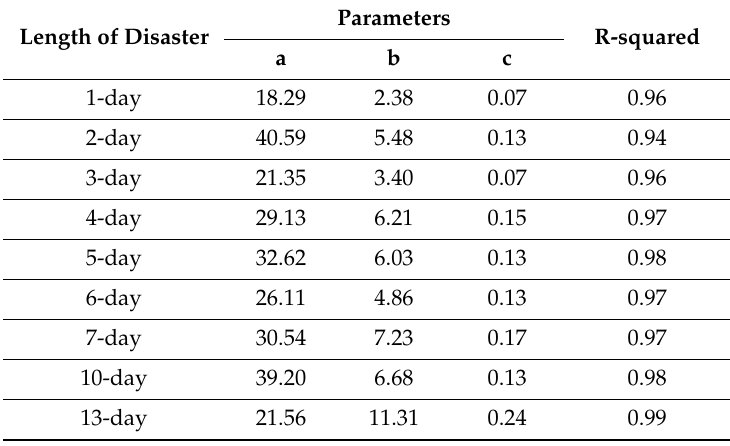
Table 6. Parameters of rainfall equation for damage occurrence of urban area by length of disaster occurrence